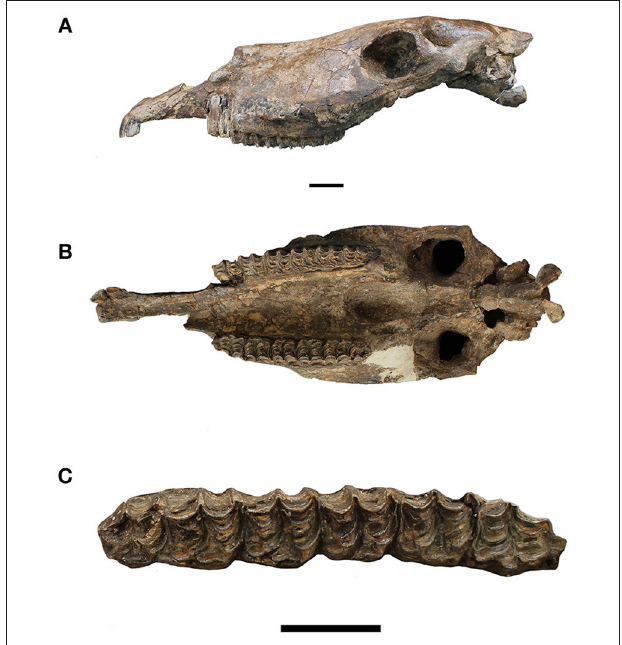
FIGURE 9 | Equus koobiforensis . (A) Skull in lateral view; (B) Skull in ventral view; (C) Upper tooth row in occlusal